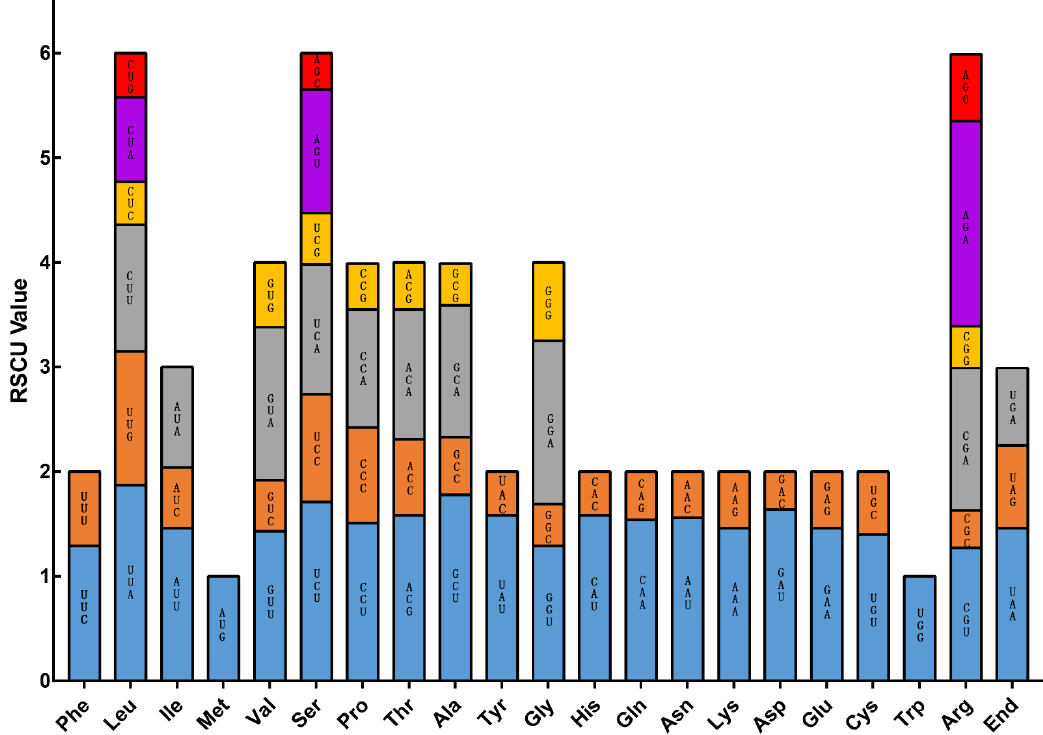
Figure 4. Codon usage bias reflected by RSCU values of codons for each amino acid.